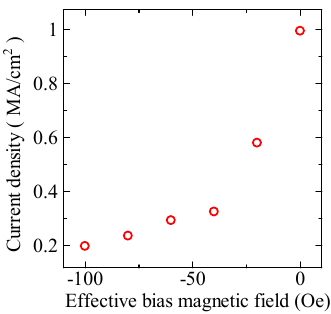
Figure 4. The current density, J c , in an MTJ device as a function of magnetic field.